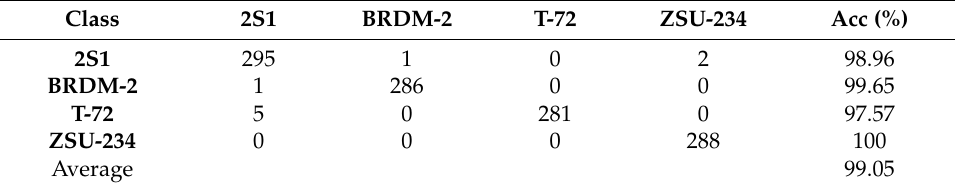
Table 4. The confusion matrix under EOC1 based on the proposed method.